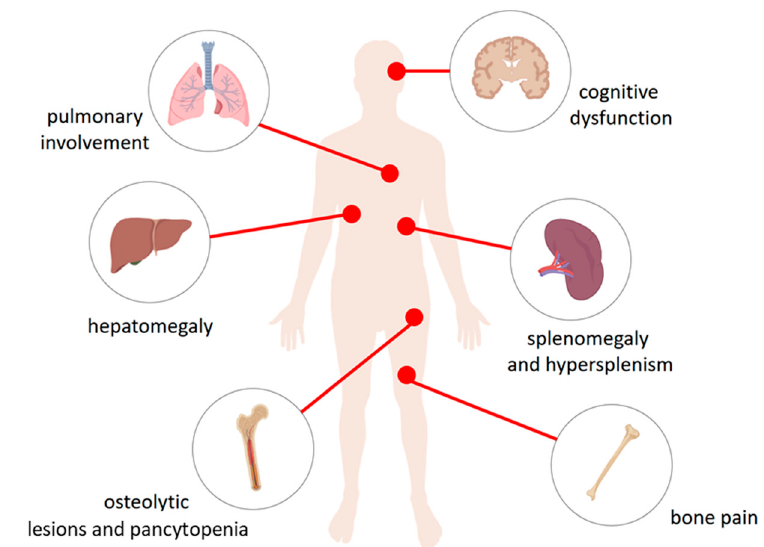
Figure 1. The physiological consequences of accumulation of glucocerebroside in the lysosomes of the reticuloendothelial system cells. Macrophages loaded with glucocerebroside (Gaucher cells) infiltrate various tissues and organs to varying degrees depending on the type of disease and causing their dysfunction. They affect the liver causing hepatomegaly, spleen—splenomegaly and hypersplenism, bone and bone marrow—osteolytic lesions and pancytopenia in type 1, 2, and 3 disease, bone pain as well as the central nervous system in the types Neuropathic 2 and 3 causing cognitive dysfunction. Gaucher cells were also recorded in lungs.